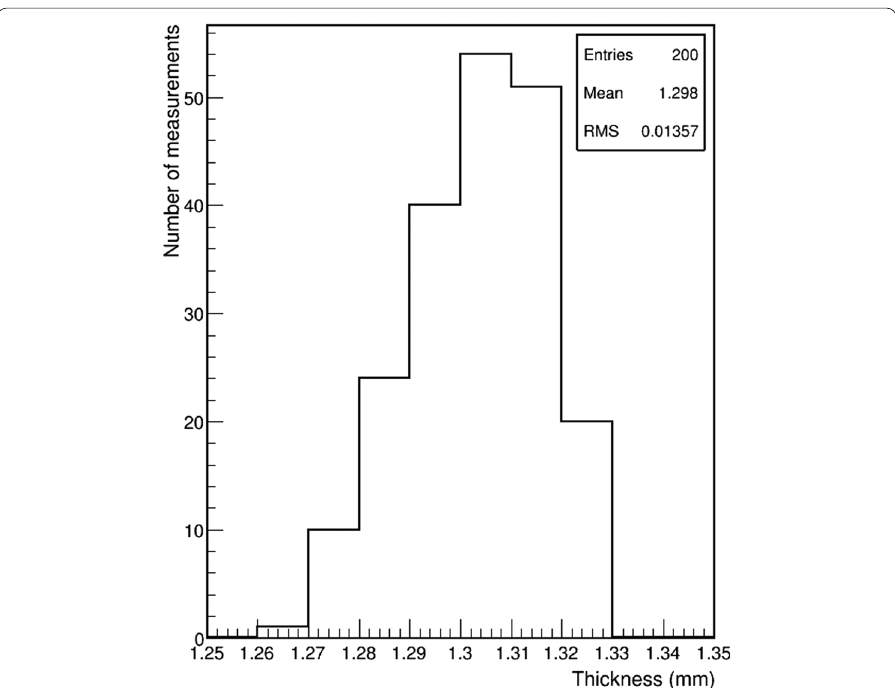
Fig. 8 Distribution of the thickness measured for 10 points over the circumference of 20 sterile glass vials